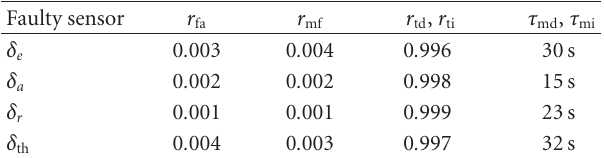
Table 8: NLGA Monte Carlo analysis with ν = 12 and p = 10%.